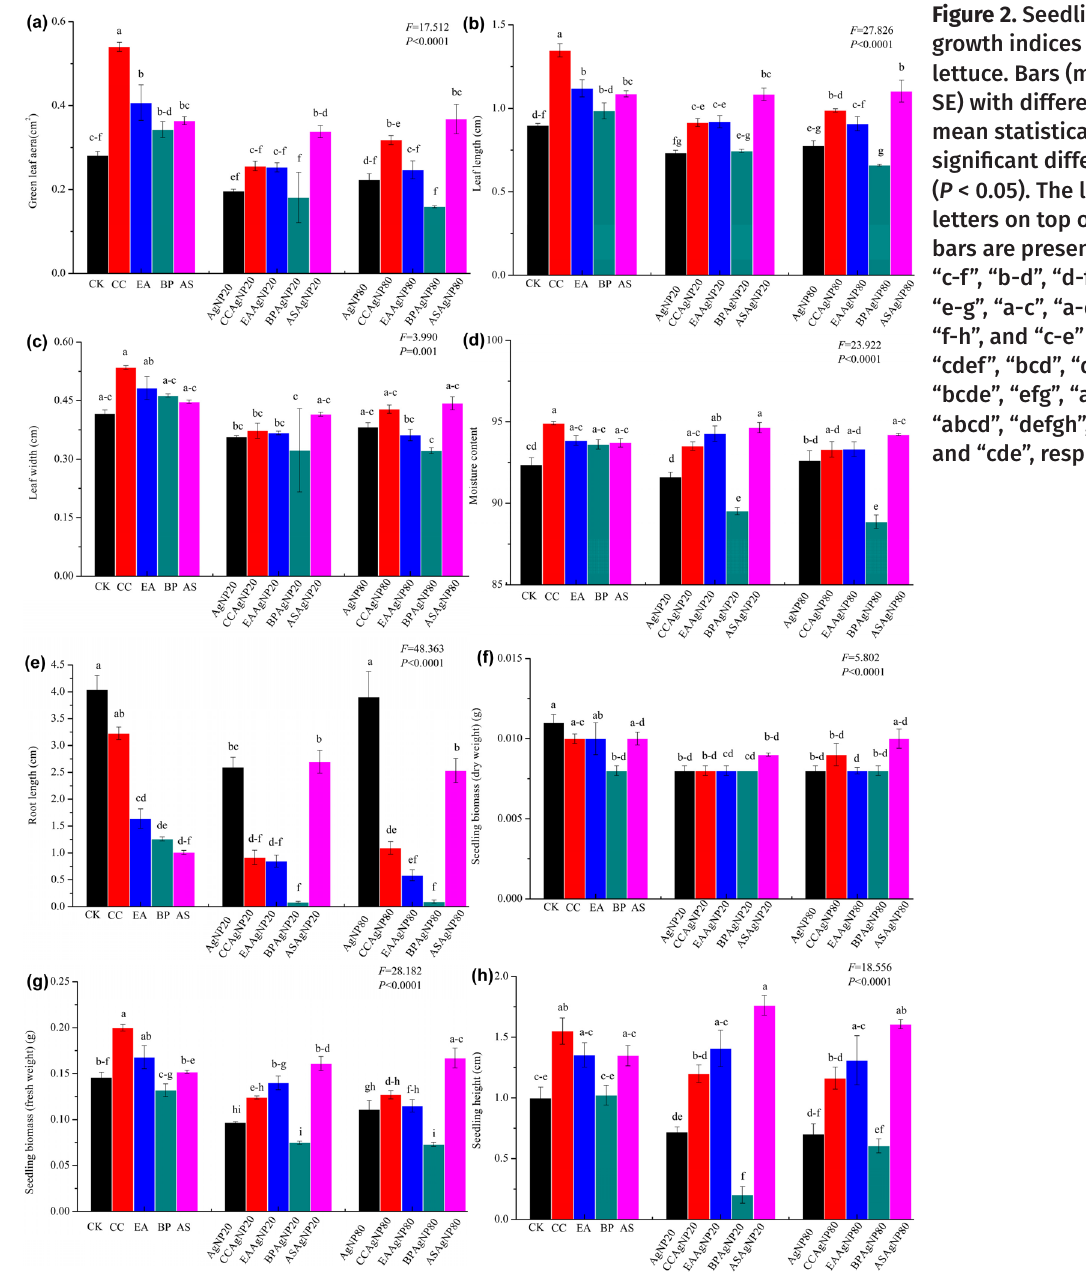
Figure 2. Seedling growth indices of lettuce. Bars (means ± SE) with different letters mean statistically significant differences ( P < 0.05). The lowercase letters on top of the bars are presented as “c-f”, “b-d”, “d-f”, “b-e”, “e-g”, “a-c”, “a-d”, “d-h”, “f-h”, and “c-e” means “cdef”, “bcd”, “def”, “bcde”, “efg”, “abc”, “abcd”, “defgh”, “fgh”, and “cde”,